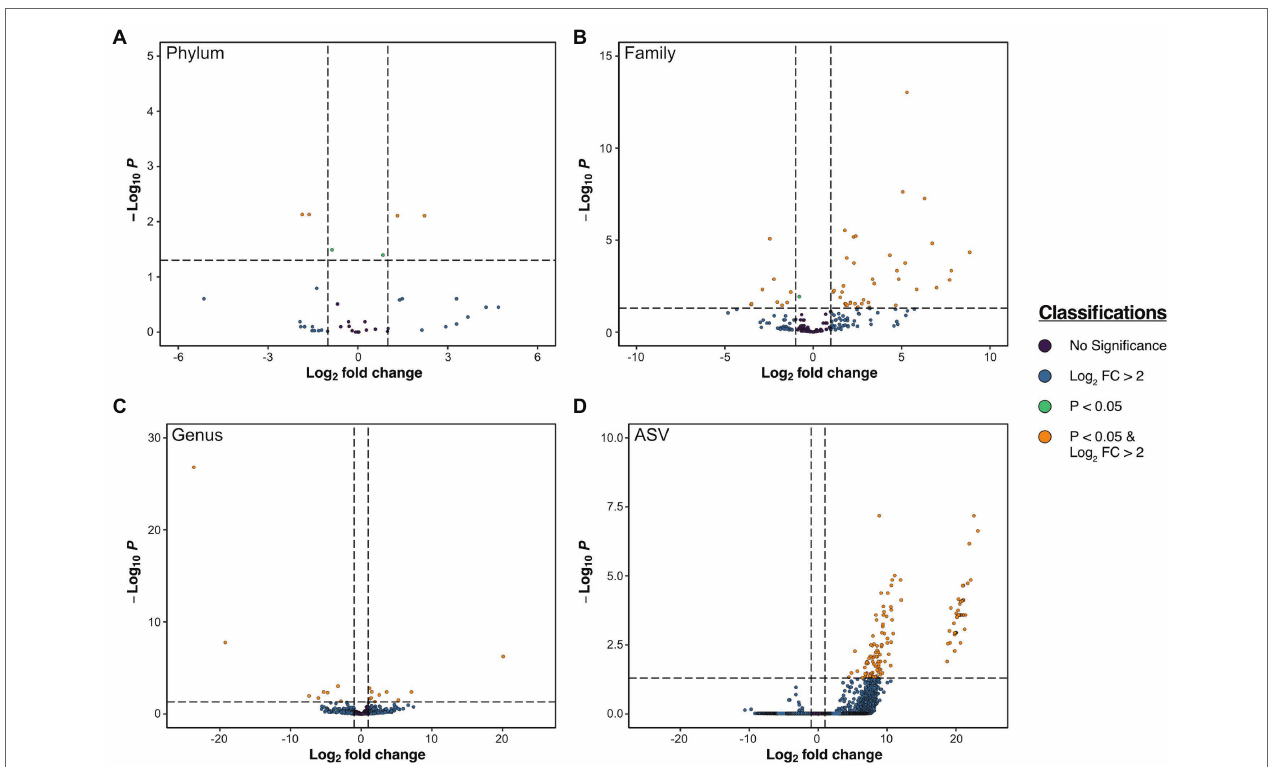
FIGURE 6 | Volcano plots of differentially abundant taxa according to DESeq2 results between tubes and sediment at the phylum (A) , family (B) , genus (C) , and ASV (D)